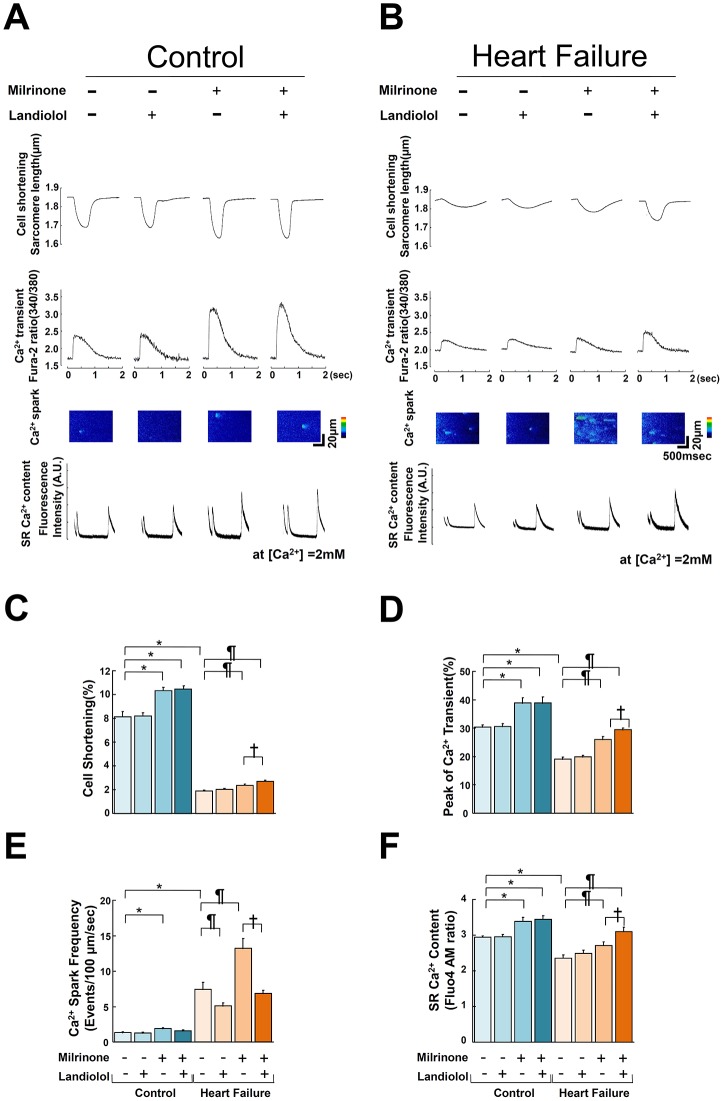
Effect of milrinone or landiolol on cell shortening, Ca2+ transient, Ca2+ spark, and sarcoplasmic reticulum Ca2+ concentration in normal and failing cardiomyocytes.A, B. Representative data for cell shortening, Ca2+ transient, diastolic Ca2+ spark, and SR Ca2+ content in control and failing cardiomyocytes. -, no treatment; +, 10 μM milrinone or 10 nM landiolol. C, D, E, F. A bar graph representation of the data in Fig. 3A, B. The bars indicate the mean (SE). Each group included 20–30 cells. At least 4 cells were evaluated for each preparation.* P<0.05 vs. control (baseline), ¶
P<0.05 vs. failure (baseline), †
P<0.05 vs. failure (monotreatment with milrinone).